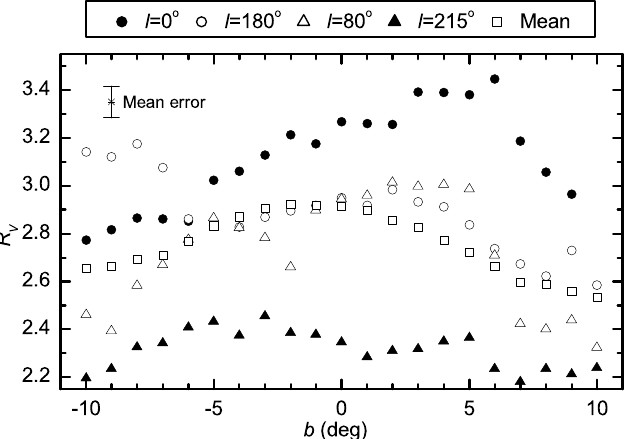
Fig. 2. The dependence of the parameter R V on Galactic latitude for selected Galactic